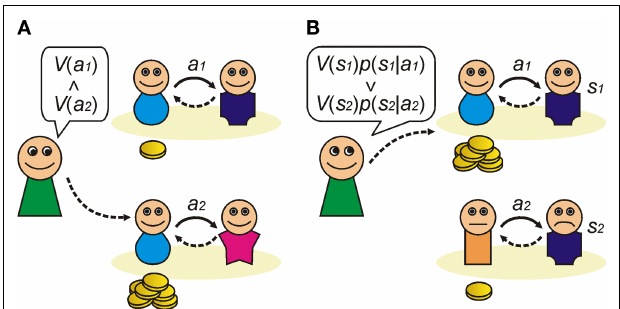
FIGURE 3 | Observation learning of Prisoner’s dilemma. Observers learn the strategy from the observation of other players playing a game. (A) Imitation learning. An observer estimates the value of action a from other players’ actions and simply imitates an action which maximises the payoff in a particular environment, which can be defi ned by game or opponent (or both). Here we show an example in which the environment is ‘game = y ’ and it does not take into account the opponent’s type ( x ) who they are playing with. (B) Inverse reinforcement learning. An observer estimates the players’ value from their actions, for example using subgoals. This means the observer assumes that the players using a model-based learning; i.e. they have a forward model of their opponents. For example, in a repeated Prisoner’s dilemma, cooperative actions ( a ) will predict a state of the other players’ happiness ( s ) which leads 1 1 mutual cooperation in the future. The value of action a is calculated as the value of state (e.g. other player’s emotional state), V ( s ), multiplied by the probability of occurrence of the state followed by the action, p ( s | a